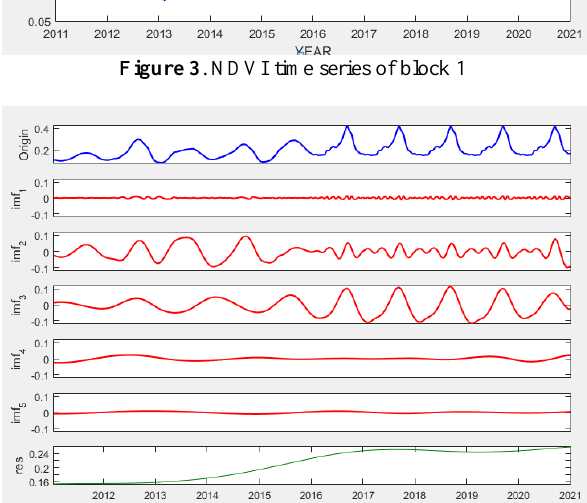
Figure 4 . NDVI time series decomposed results using EMD In figure 4, the time series (blue line) is decomposed into 5 IMFs (red line) and a residue (green line). The imf 1 , which was close to white noise, was subtracted from the original. Two